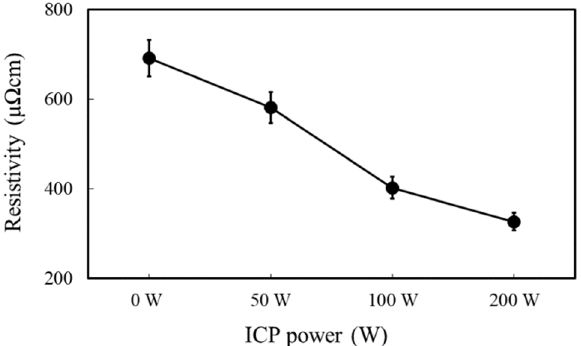
Figure 7. Electrical resistivity of MoN coatings deposited using ICP assisted sputtering with various ICP powers.